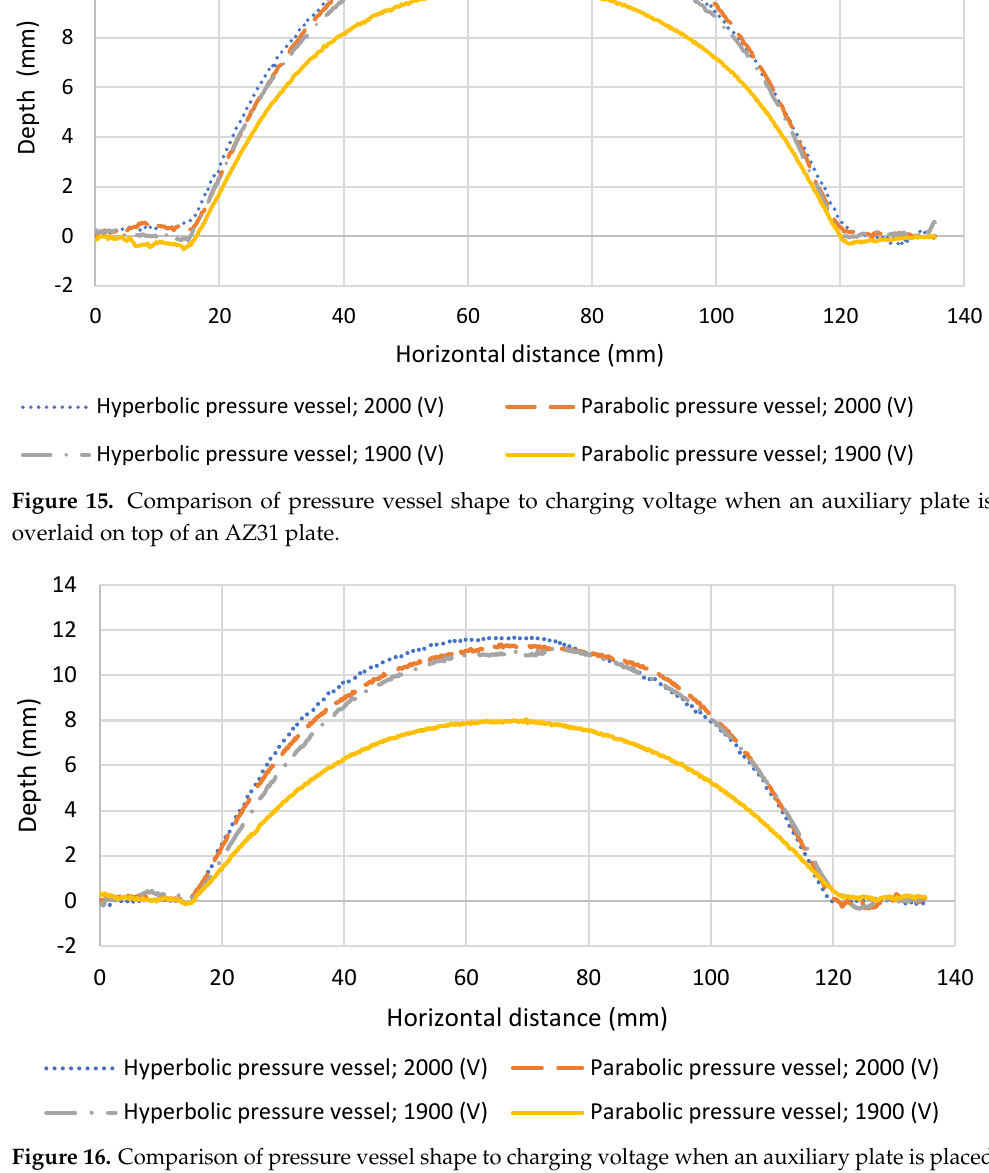
Figure 15. Comparison of pressure vessel shape to charging voltage when an auxiliary plate is over- laid on top of an AZ31 plate.